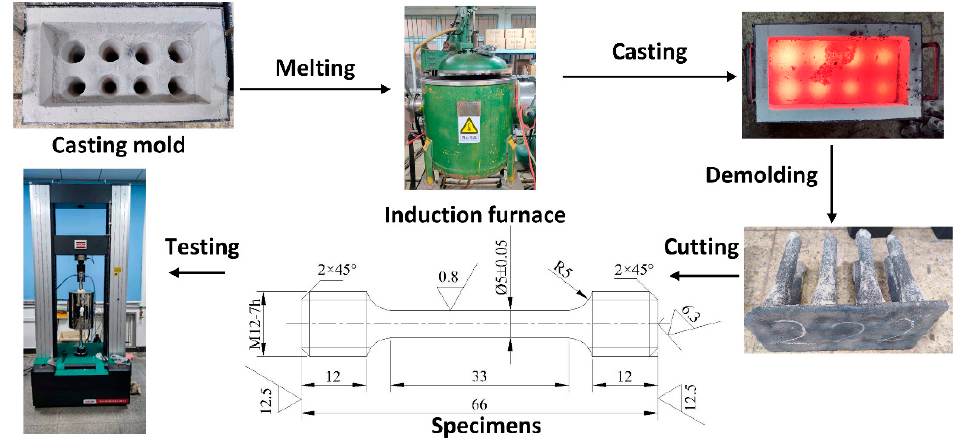
Figure 12. Tensile test specimen preparation and testing.